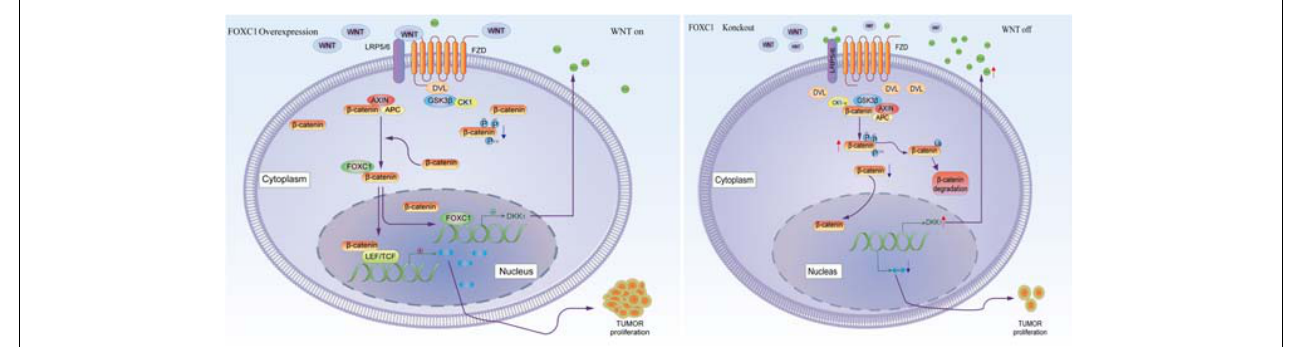
FIGURE 8 | Schematic depicting the role of FOXC1 and DKK1 in the regulation of gastric cancer proliferation. FOXC1 is overexpressed in gastric cancer cells and acts as a transcription factor that negatively regulates DKK1 expression by binding to its promoter region, thereby modulating the activation state of the Wnt signaling pathway and upregulating expression of c-MYC, promoting the proliferation of GC cells. At the same time, FOXC1 also forms a complex with the unphosphorylated β -catenin (Ser33/37/Thr41) protein in the cytoplasm but dissociates in the nucleus.